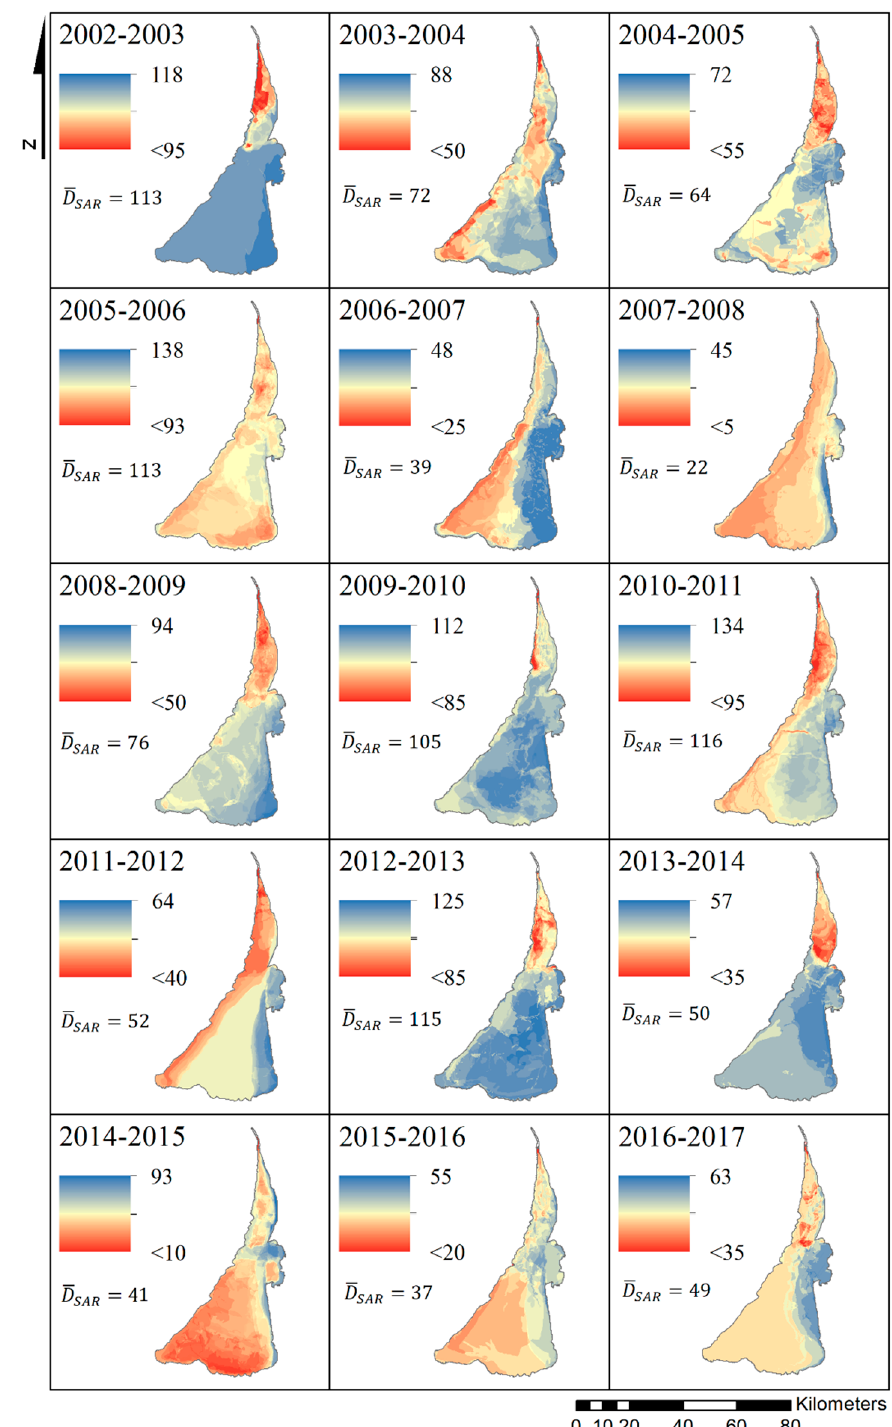
Figure 11. Yearly maps of the ice season duration in the Curonian Lagoon obtained from satellite data in